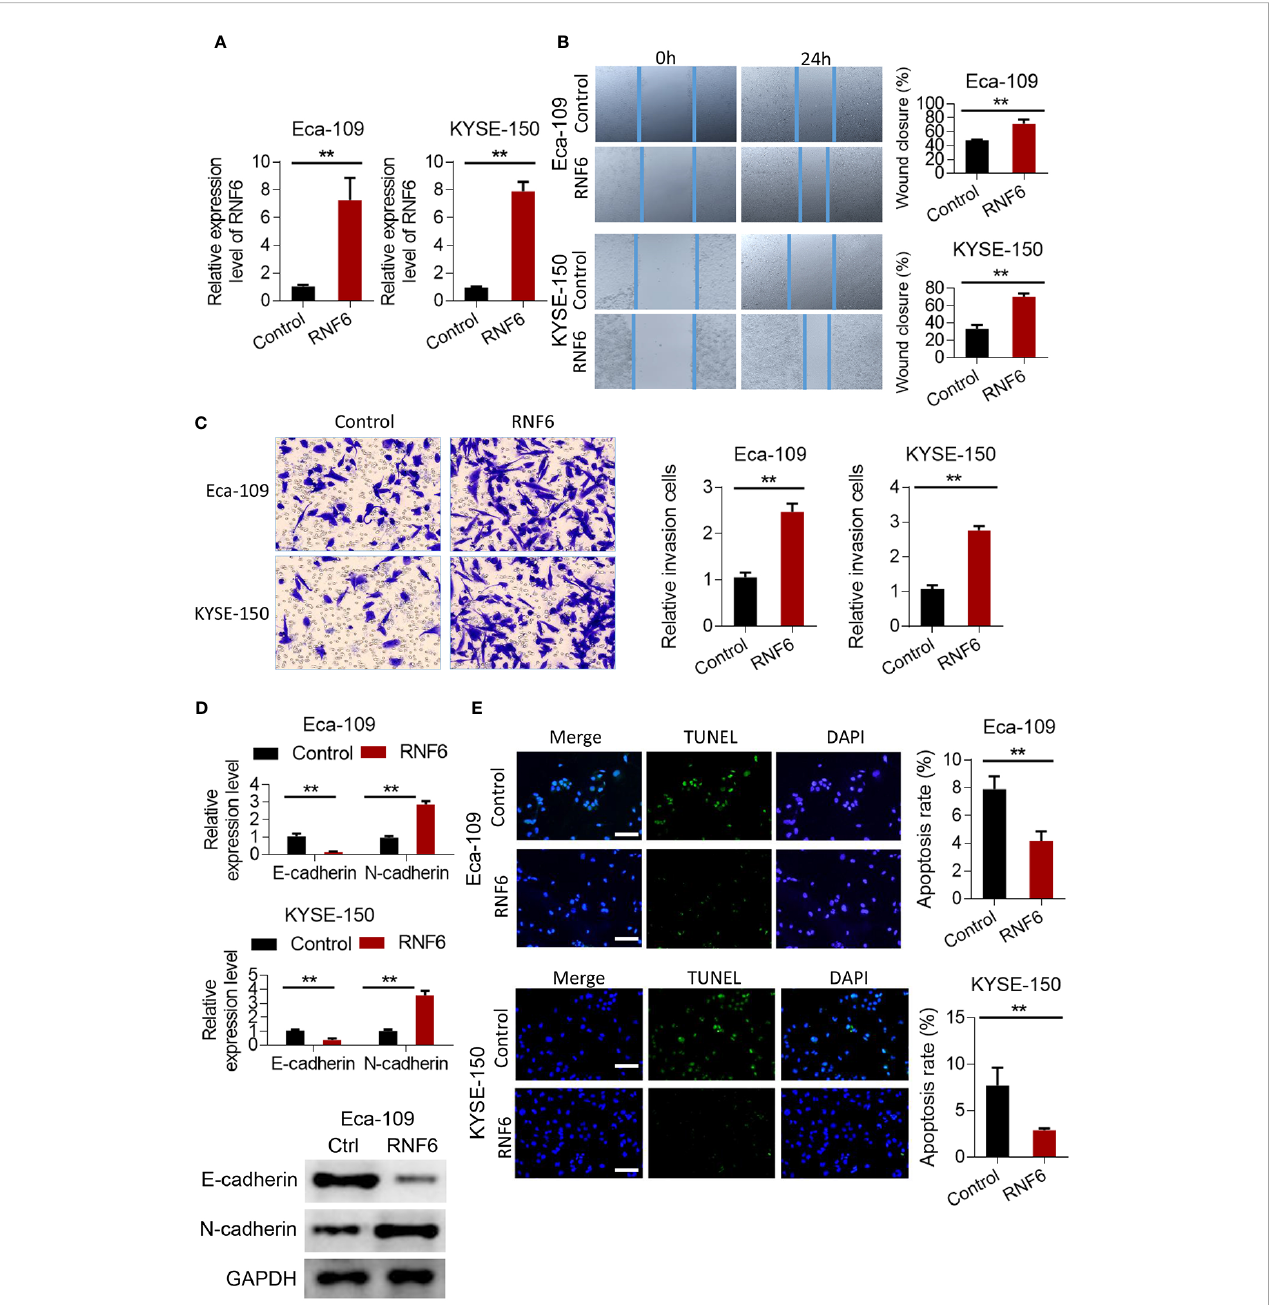
FIGURE 2 RNF6 promotes migration and invasion of esophageal cancer cells in vitro . (A) Overexpression ef fi ciency assay. (B) Effect of overexpression of RNF6 on wound healing. (C) Effect of overexpression of RNF6 on cell invasion. (D) Changes in E-cadherin and N-cadherin levels after RNF6 upregulation. (E) Cell apoptosis was detected by TUNEL after overexpression of RNF6. Scale bar: 50 µm. n=3, **P <